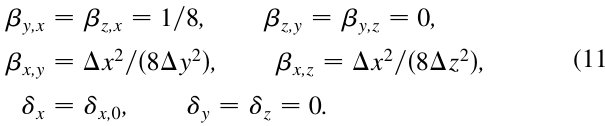
, as deduced (cid:5);x and k for electromagnetic x y ¼ 0 ). The blue horizontal z ¼ (cid:6)c , and there is no intersection (cid:5);x (cid:1) 0 z